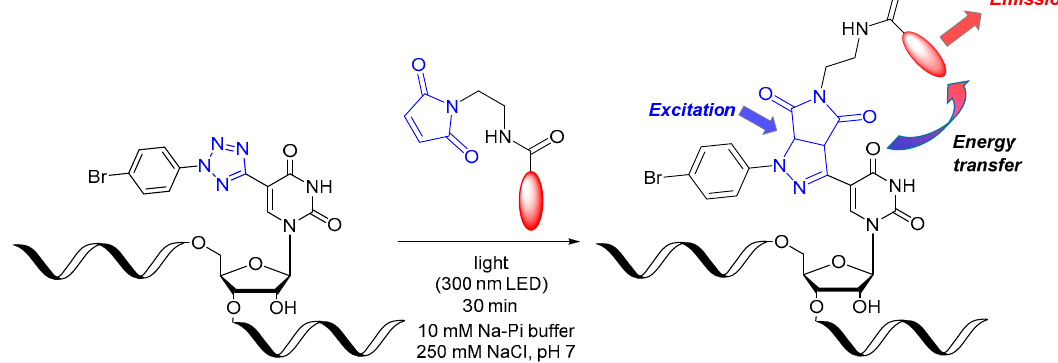
Figure 1. Principle of fluorogenic RNA photoclick labeling using the tetrazole-modified uridine (marked in blue, for building block structure see Scheme 1) as a photoreactive building block in single-stranded RNA and maleimide-conjugated dyes (maleimide marked in blue, dye in red). The energy transfer between the pyrazoline as a photoclick product and the attached dye yield a fluorogenic photoclick reaction.